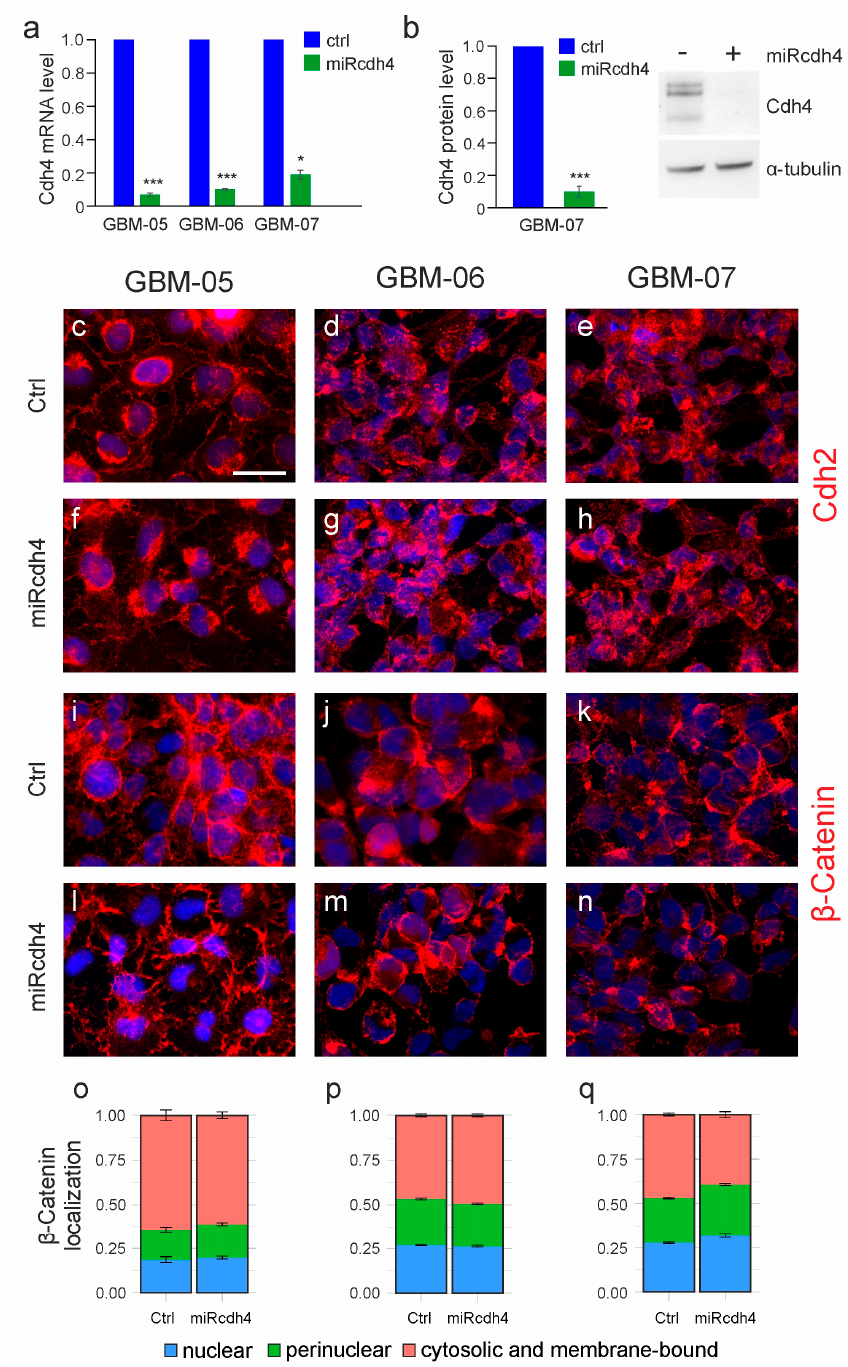
Figure 3. Effect of the miRcdh4 transduction in GICs. ( a , b ) Quantification of Cdh4 mRNA expression by quantitative PCR ( a ) or protein expression by western blot ( b ) of Cdh4 silenced GICs compared to control transduced GIC cultures. ( c – n ) Representative immunofluorescence stainings with anti-Cdh2 ( c – h ) or anti- β -catenin ( i – n ) antibodies of different Cdh4 silenced or control transduced human GIC cultures. Nuclei are showed in blue using Hoechst. Scale bar: 25 µ m. ( o – q ) Subcellular localization of β -catenin immunoreactivity in the different GIC cultures upon miRcdh4 or control transduction, assessed by image analysis. Values are reported as fraction of total β -catenin signal. * p < 0.05, *** p <